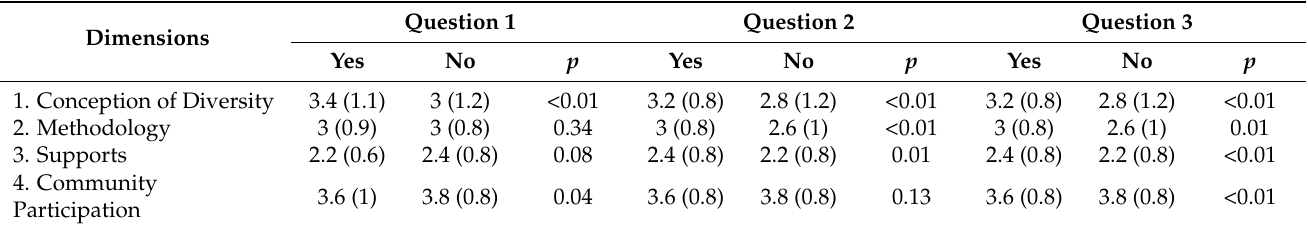
Table 3. Analysis of the differences of each dimension of the CEFI-R according to the answers to the dichotomous questions.